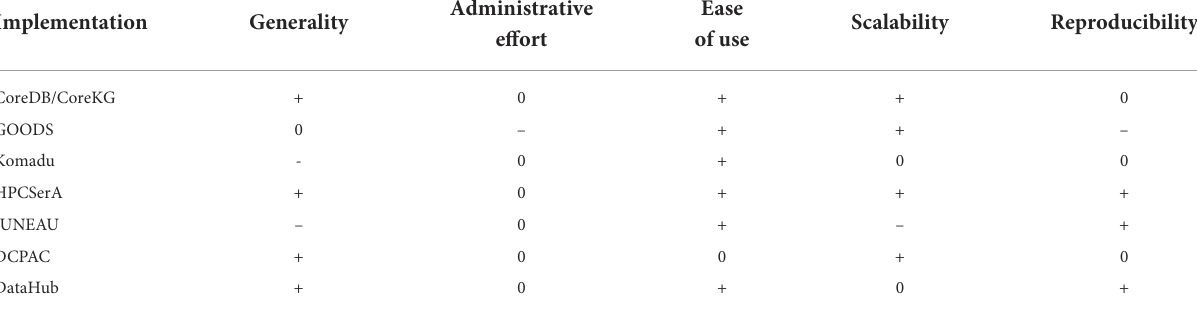
TABLE 3 Comparing the seven provenance models. Implementation